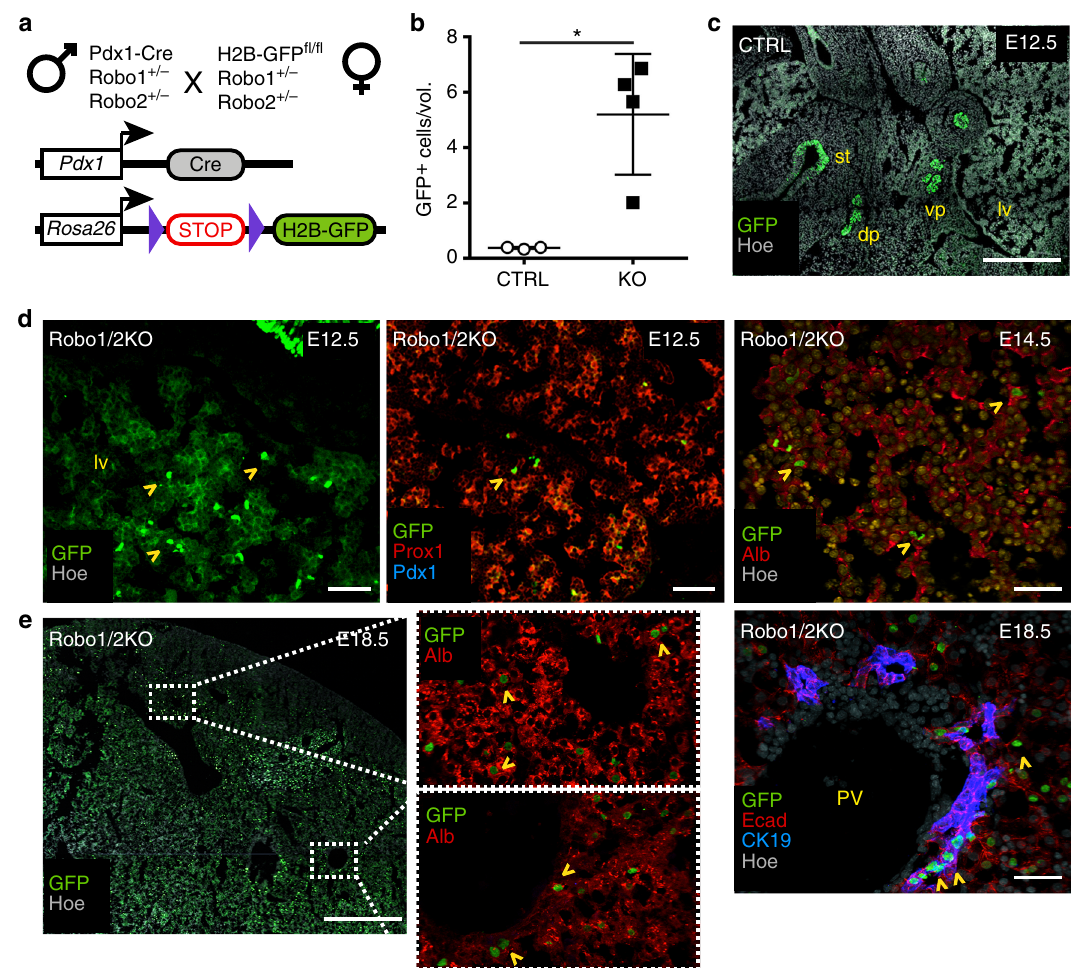
Fig. 5 Lineage tracing of Pdx1 -expressing progenitors in Robo1/2 KO embryos. a Schematic representation of the transgenes and breeding scheme used for lineage tracing experiments in Robo1/2 KO embryos. b Quanti fi cation of GFP + cells in the E12.5 liver of CTRL ( n = 3) and Robo1/2 KO ( n = 4) embryos. Number of GFP + cells was normalised to the liver bud volume. Error bars represent ± s.e.m. Two-tailed Student ’ s t -test * P < 0.05. c Representative tiled IF image of E12.5 Pdx1-Cre;H2B-GFP;Robo1 + / + /Robo2 + / + (CTRL) cryosections stained for GFP and Hoechst (Hoe) nuclear counterstain. As expected, cells in ventral pancreas (vp), dorsal pancreas (dp), stomach (st) and duodenum were labelled by Pdx1-Cre 24,29 . Scale bars, 200 µ m. d Representative IF images of E12.5 and E14.5 Pdx1-Cre;H2B-GFP;Robo1/2 KO (Robo1/2 KO) cryosections stained with indicated antibodies and Hoechst (Hoe) as nuclear counterstain. Arrowheads indicate GFP + cells in the liver (lv), which are also Prox1 + or Albumin + (Alb). e Representative IF images of E18.5 Pdx1-Cre;H2B- GFP;Robo1/2 KO (Robo1/2 KO) cryosections stained with indicated antibodies and Hoechst (Hoe) as nuclear counterstain. Arrowheads indicate GFP/ Albumin (Alb)-double positive cells in the hepatic parenchyma and GFP/CK19-double positive cells in the portal vein (PV) space. Scale bars, 50 µ